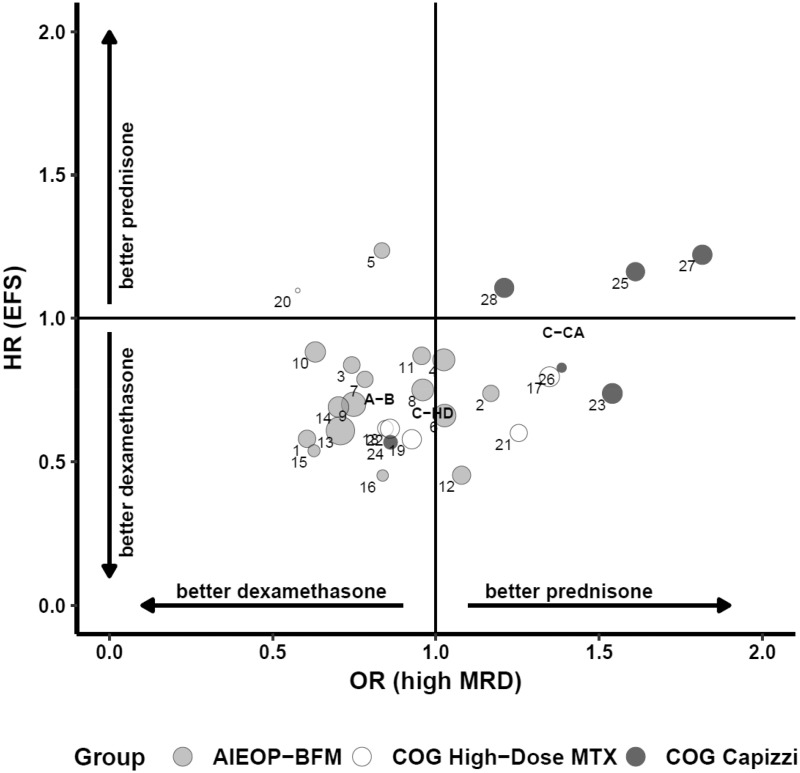
Trial level association between estimated (copula model) treatment effects (dexamethasone vs prednisone) on minimal residual disease (MRD) (odds ratio [OR]) vs event-free survival (EFS) (hazard ratio [HR]) in the 28 trial units that are represented with circles with size proportional to their sample size. Shading distinguishes trial units within main groups, whose overall effects are also represented.